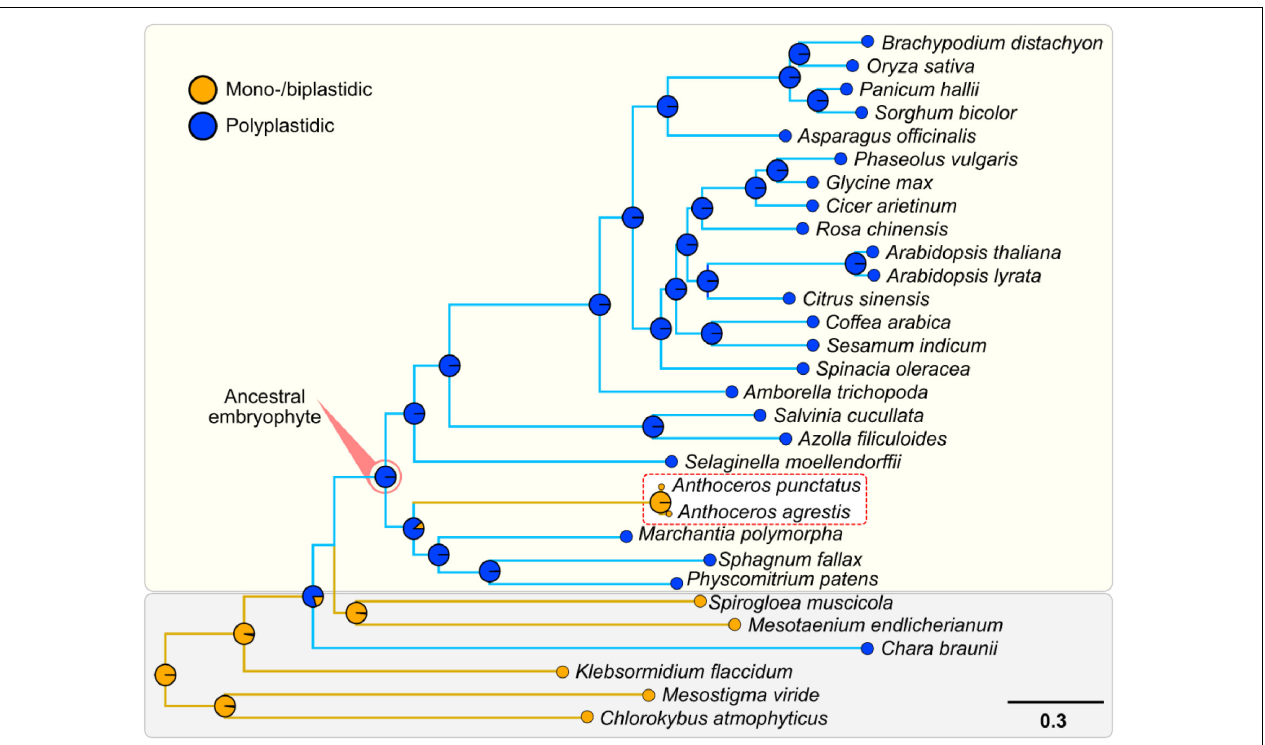
FIGURE 2 | Support for the polyplastidic nature of the ancestral embryophyte and monoplastidic nature of the ancestral hornwort. Pie charts at the nodes display estimates of the probabilities for the plastidic phenotype of the respective most recent common ancestors (MRCAs). Hornworts are highlighted with a white box and a red dotted line. A robust ML species phylogeny of the green lineage was constructed via the IQ-TREE version 2.0.3 (Minh et al., 2020), using an automated selection model, by concatenating several housekeeping genes identified with DIAMOND in 34 different streptophytes, seven chlorophytes, and one glaucophyte ( Supplementary Tables 3 , 4 ; Buchfink et al., 2015). We used a reciprocal best hit pipeline with DIAMOND (Buchfink et al., 2015), to analyze the genomes of 34 different streptophytes to determine the presence and absence of orthologs involved in plastid division, to estimate the presence/absence of ARC3 and FtsZ2 at various nodes on our tree ( Supplementary Table 5 ). Subsequent ASRs were undertaken using the ape function from the Phytools package (Revell,